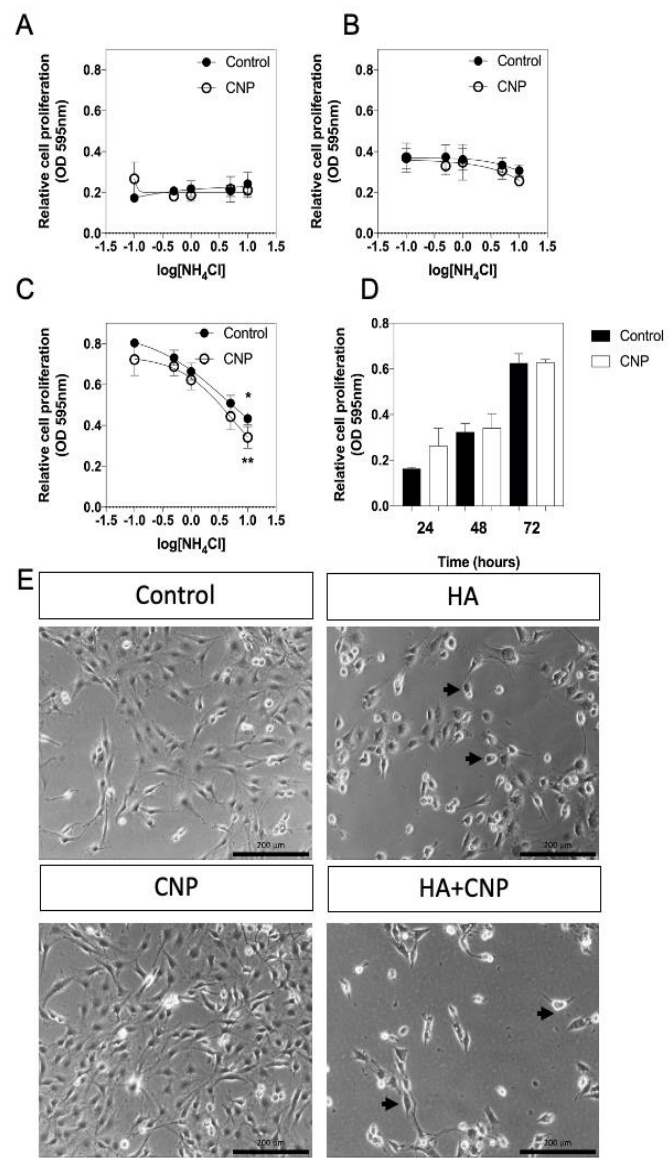
Figure 2. Effects of hyperammonaemia and CNP on cell proliferation and morphology in rat C6 glioma cells. C6 cells were treated with the indicated concentrations of NH 4 Cl (log mM) (as an NH3 donor) in the absence or presence of 100 nM CNP for ( A ) 24 h, ( B ) 48 h or ( C ) 72 h, before being fixed in paraformaldehyde, and stained for crystal violet assay. The data shown are means ± SEM pooled from 3 independent experiments, each performed with 8 replicates. * p < 0.05, ** p < 0.01, significantly different from untreated cells. ( D ) Cell viability in C6 cells in the presence of 0 or 100 nM CNP over 72 h. The data shown are means ± SEM pooled from 3 independent experiments, each performed with 8 replicates. ( E ) Representative microscopy images of C6 cells treated for 72 h with 0 (control) or 10 mM NH 4 Cl (HA), in the presence of 100 nM CNP alone (CNP) or in combination (HA+CNP). Arrow heads indicated rounded